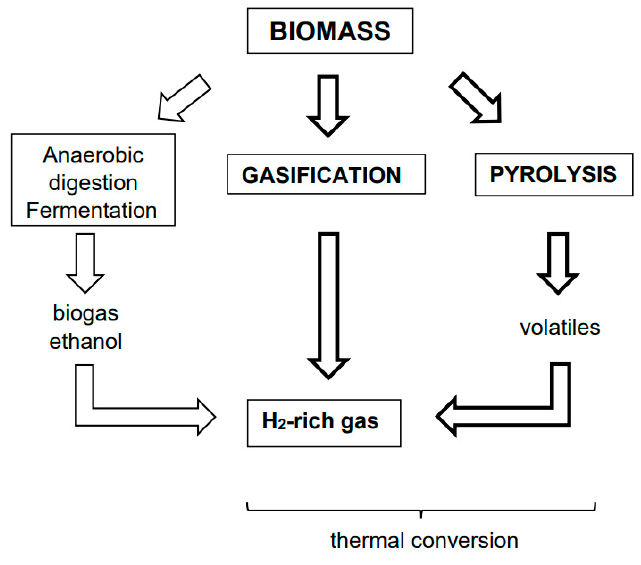
Figure 1. Methods of lignocellulosic biomass conversion to hydrogen-rich gas.